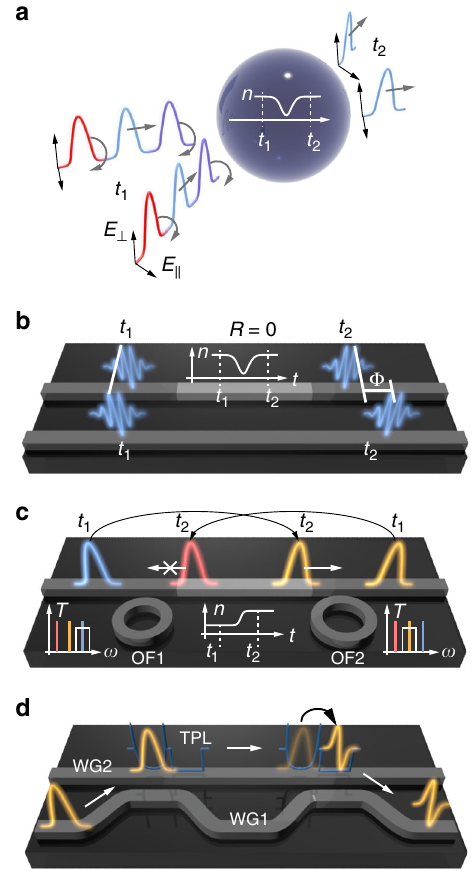
Fig. 1 Potential T-SUSY applications. a Omnidirectional, isotropic, polarisation-independent, all-dielectric (all-magnetic), 3D time-varying material that is invisible in a given (recon fi gurable) spectral region, allowing the generation of frequency-selective transparent temporal windows. b Perfect phase shifter: a short region in a waveguide (lighter grey) with a fast T-SUSY time-varying index inducing a dynamically-recon fi gurable frequency- independent re fl ectionless phase shift Φ over an optical pulse. c Optical isolator: another T-SUSY time-varying index shifts the frequency of a right- propagating pulse (blue to yellow here), which can traverse the optical fi lters OF1 and OF2. Any left-propagating pulse is re fl ected at OF1 or OF2, protecting a left-side source from external re fl ections. d Recon fi gurable pulse-shape transformer: an input pulse propagating along waveguide WG1 is spatially coupled to a T-SUSY temporal photonic lantern (TPL, a moving index perturbation) running along waveguide WG2. The pulse excites another TPL mode with a different desired shape, coupled back to